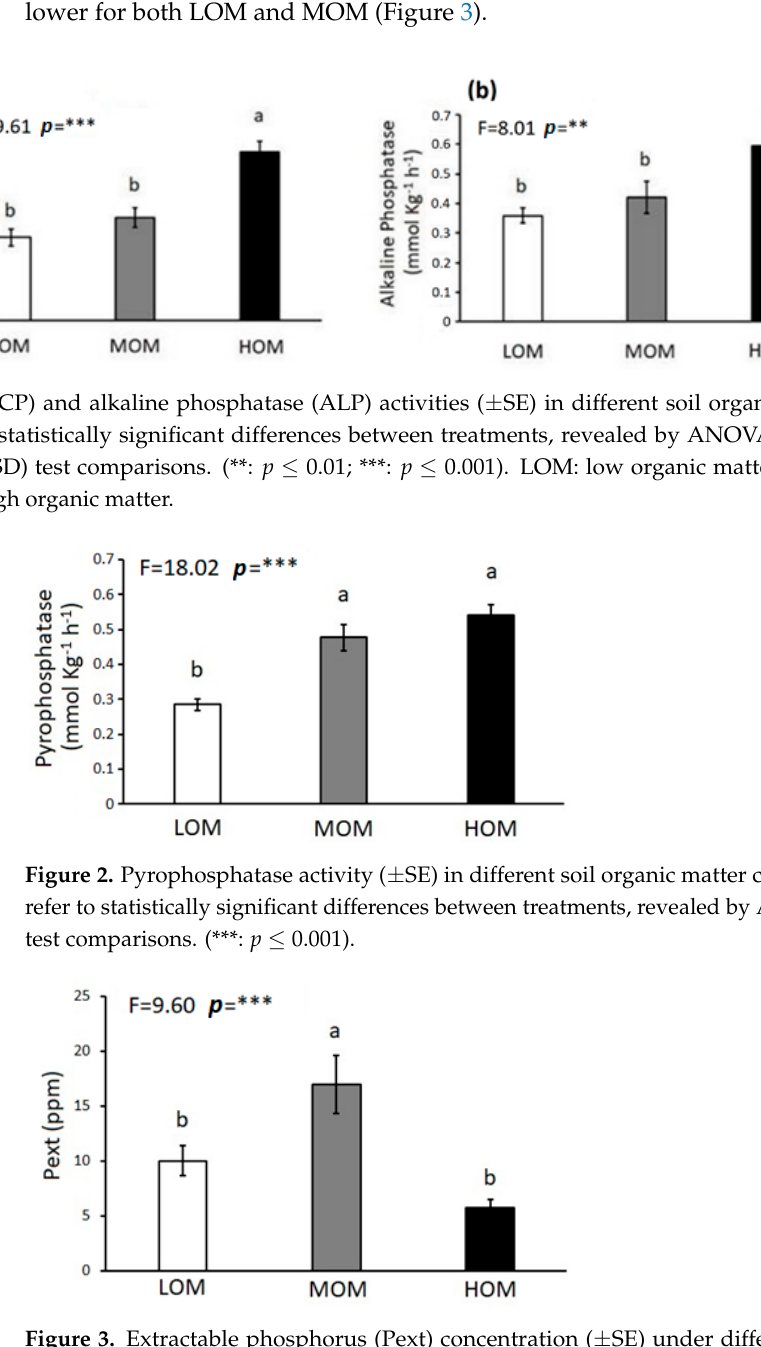
Figure 3. Extractable phosphorus (Pext) concentration ( ± SE) under different soil organic matter contents. Different letters refer to statistically significant differences between the treatments, as revealed by ANOVA and Fischer LSD test comparisons. (***: p ≤